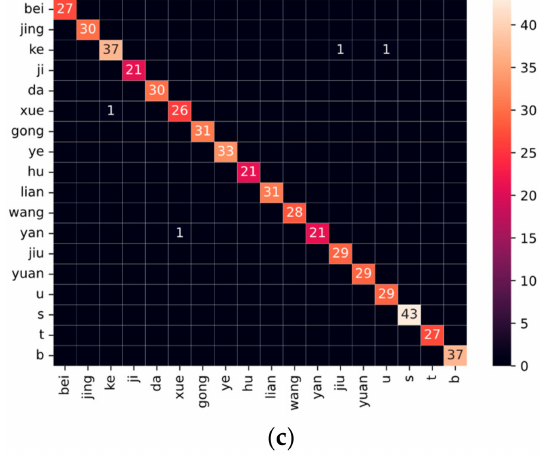
Figure 7. The accuracy distribution of each character recognition on ResNet model. ( a ) CCRNet-